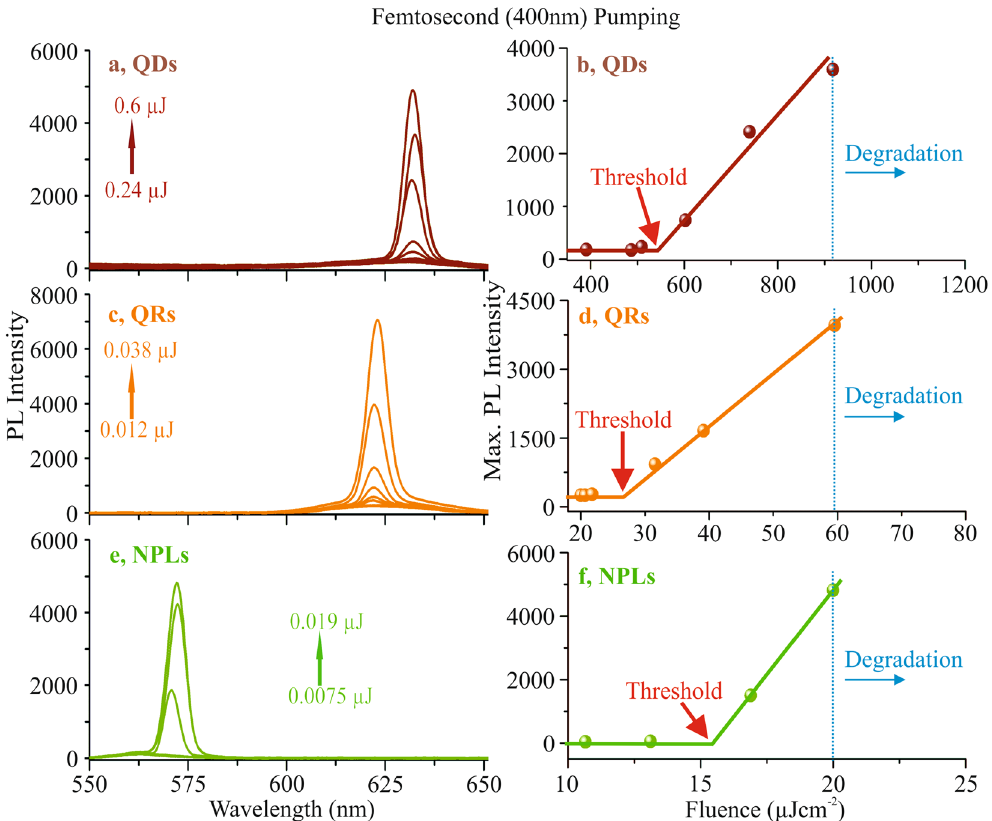
Figure 2. The comparison between QDs ( a , b ), QRs ( c , d ) and NPLs ( e , f ), measured with 2 ω pumping. The arrows in each graph (red for QDs, orange for QRs and green for NPLs) represent the energy range used. All three nanoparticles show clear indication of ASE at the peak wavelengths of 632 nm (QDs), 623 nm (QRs) and 572 nm (NPLs). The range of measured pump pulse energies are indicated in ( a , c , e ). The corresponding ASE threshold values as shown in ( b ) (QDs), ( d ) (QRs) and ( f ) (NPLs) are at the pump fluences of ≈ 542 μ J cm − 2 , ≈ 25 μ J cm − 2 and ≈ 15.42 μ J cm − 2 ,